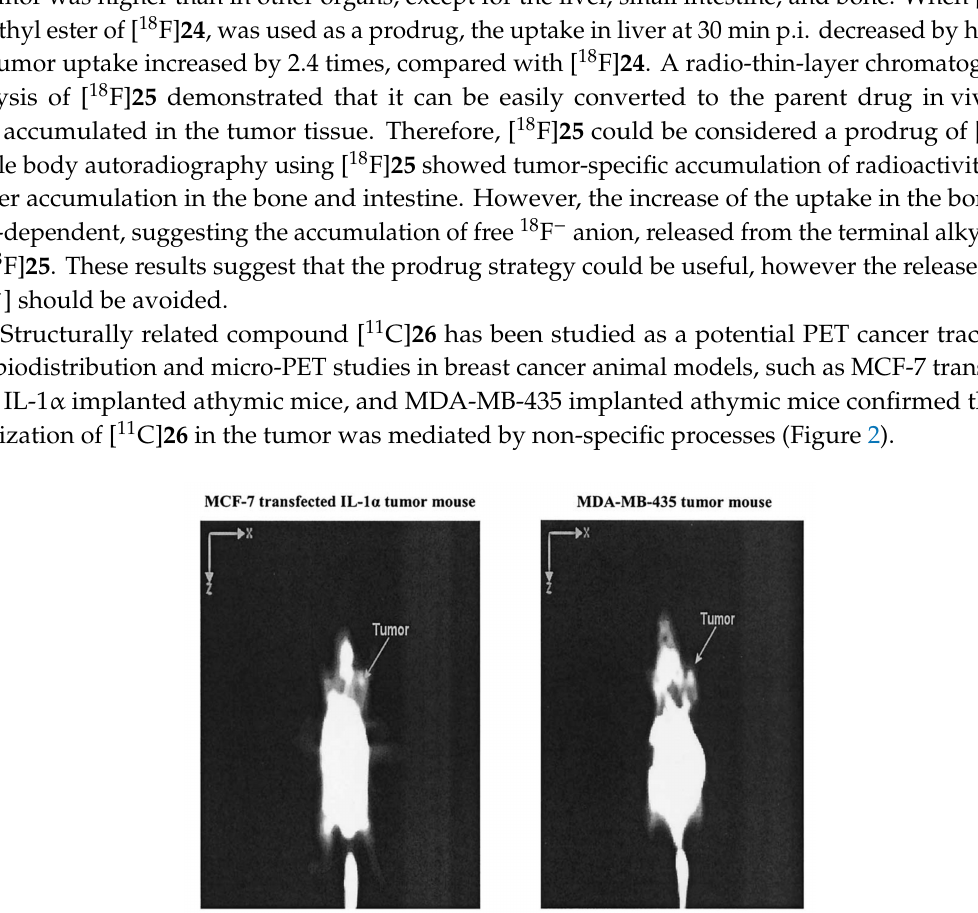
Figure 2. Micro-PET images of [ 11 C] 26 in a MCF-7 transfected with IL-1 α implanted athymic mouse, and a MDA-MB-435 implanted mouse, after an initial 30 min uptake period. Reprinted with permission from [75] Copyright © 2003 Elsevier Inc. All rights